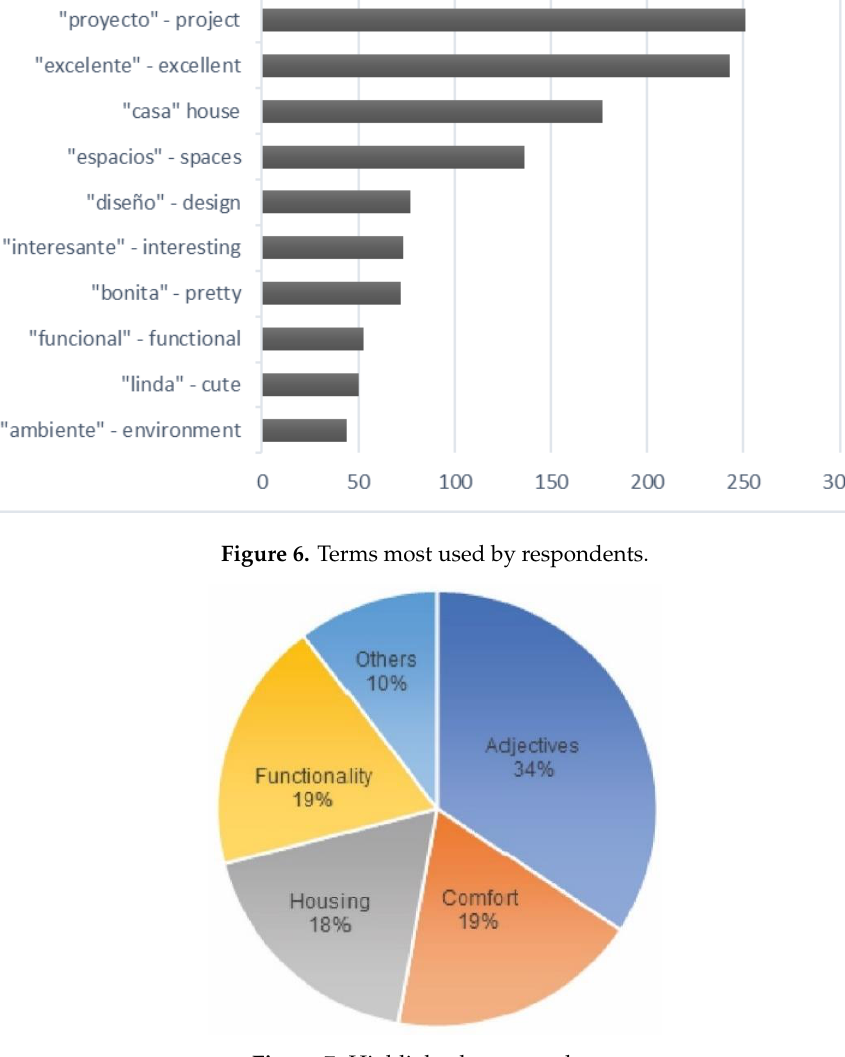
Figure 8. Health survey.